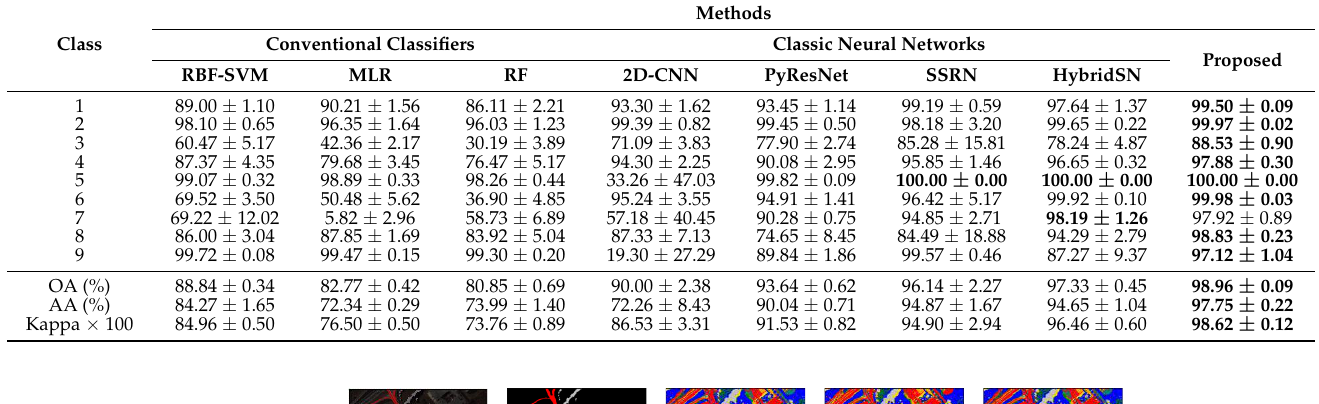
Table 5. The categorized results of different methods on the Paiva of University dataset.